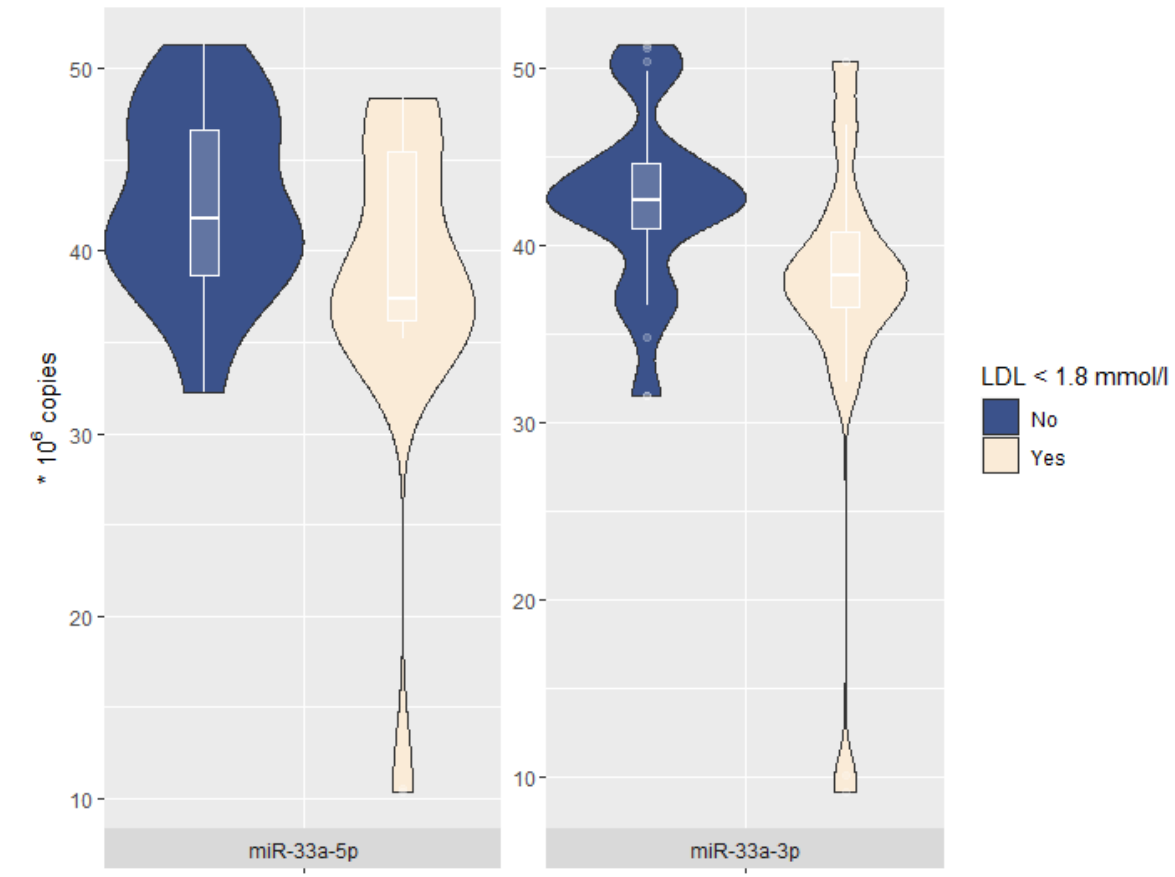
Figure 1. miR-33a-5p/3p expression levels according to target LDL levels. Combined violin-and-box-plot: the horizontal lines corresponds to the median ( center ) and first and third quartiles ( lower and upper , respectively); the shape of the violin plot reflects the distribution of the variable.